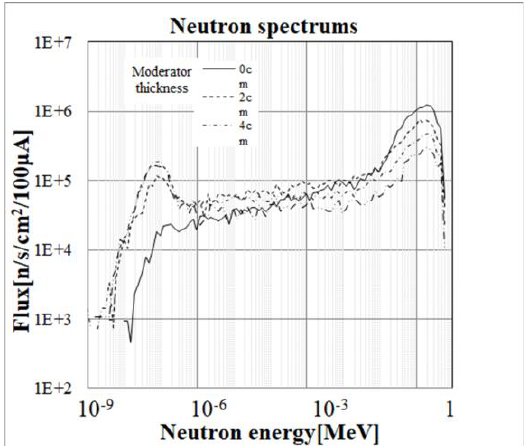
Fig.3 Neutron spectrums at the exit of target station of RANS, about 1.5 m down from the target for different kinds of polyethylene